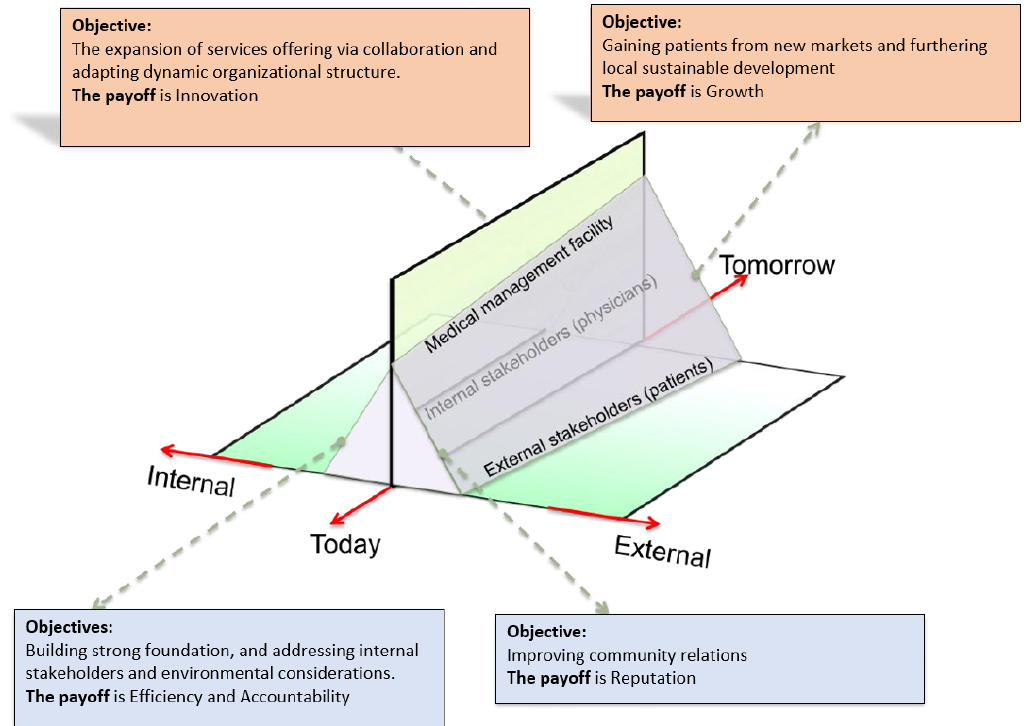
Figure 2. Framework for establishing a sustainable medical facility .